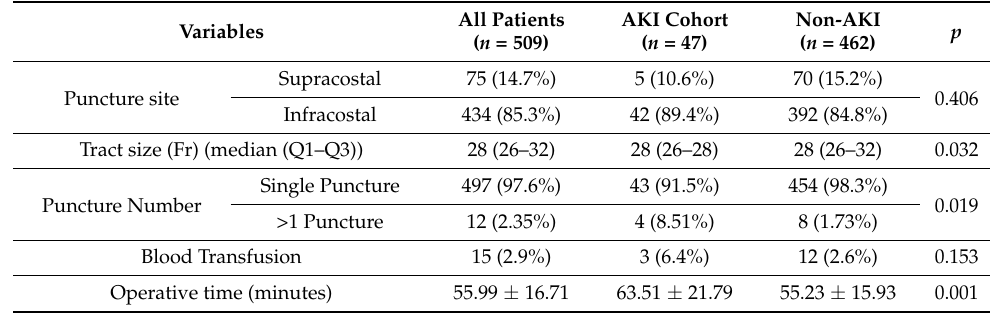
Table 3. Intraoperative data.